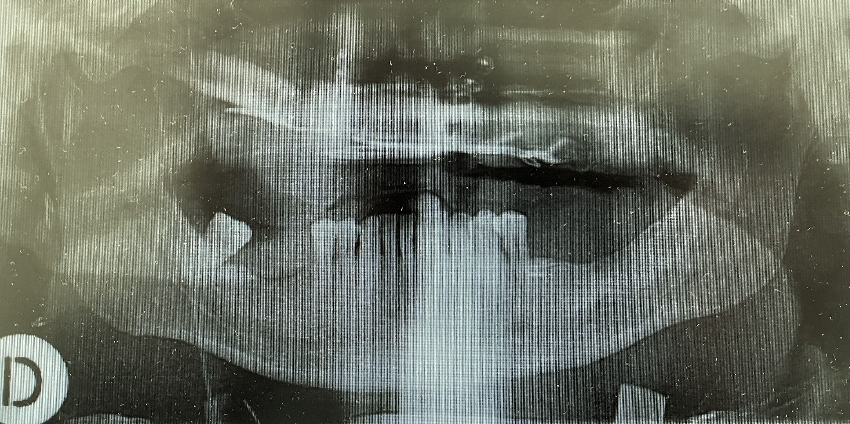
Figure 6. Post reconstruction panoral X-ray (The day after surgery). Table 1. Main surgical steps.